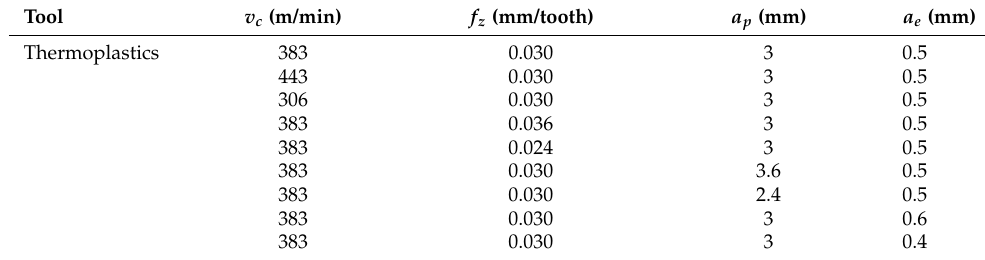
Table 3. Experimental plan of the qualification